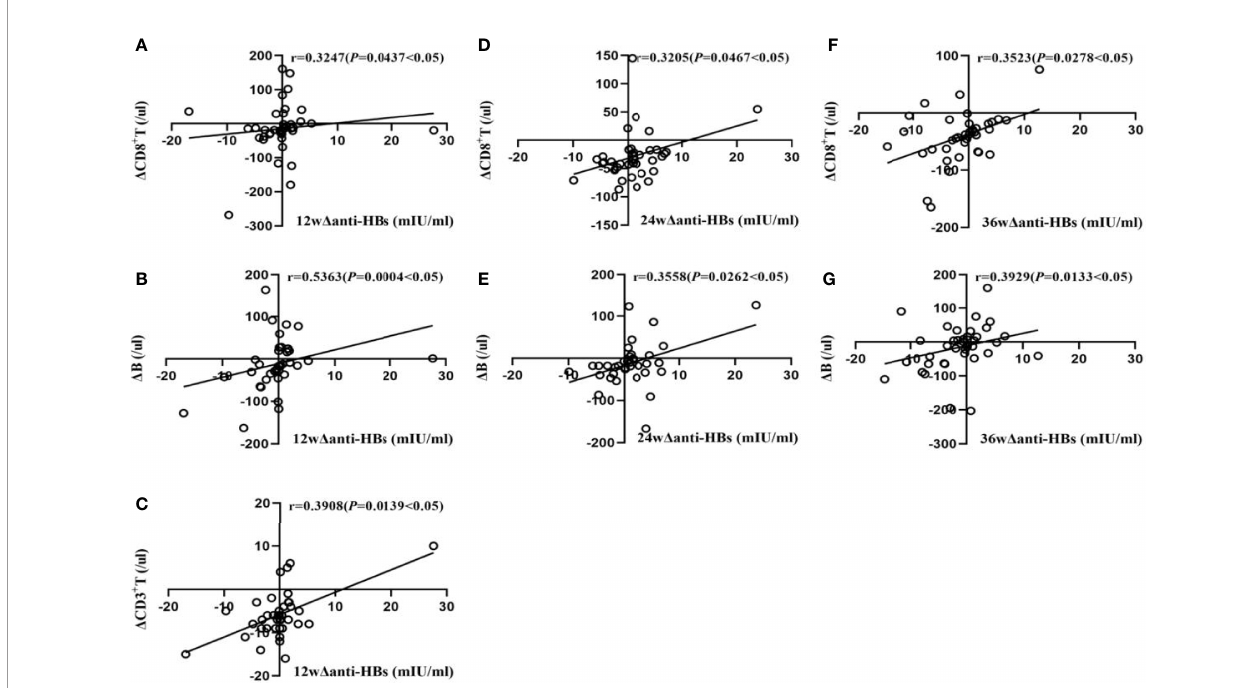
FIGURE 2 | Correlation analysis of D anti-HBs and D immune cells in Group B at week 12 (A – C) , week 24 (D, E) , week 36 (F, G)